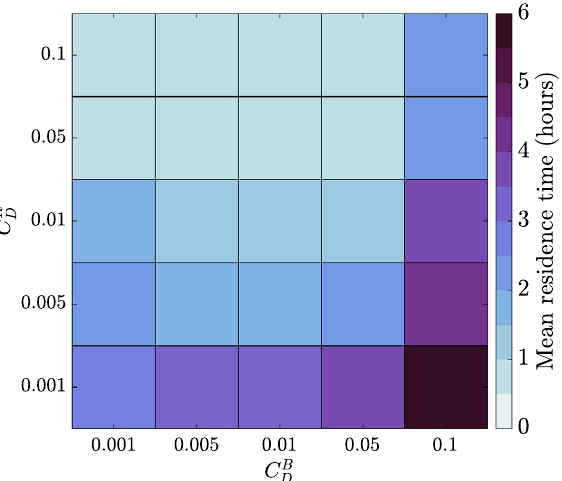
R D , and everywhere